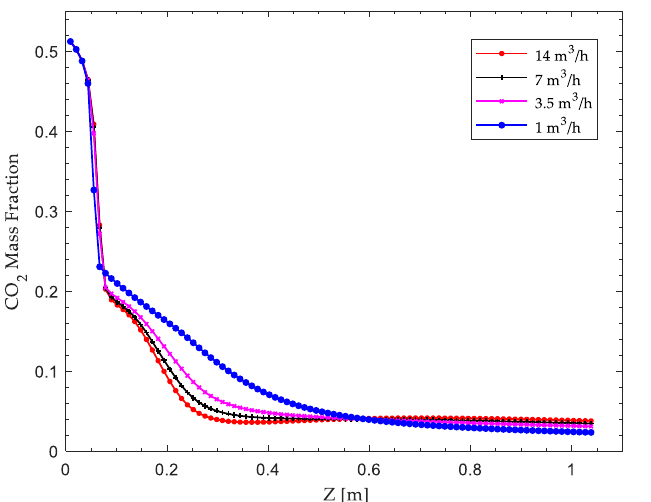
Figure 11. Effect of thermal oil feed rate on the axial CO 2 profile at representative tube centerline (1-m reactor module).